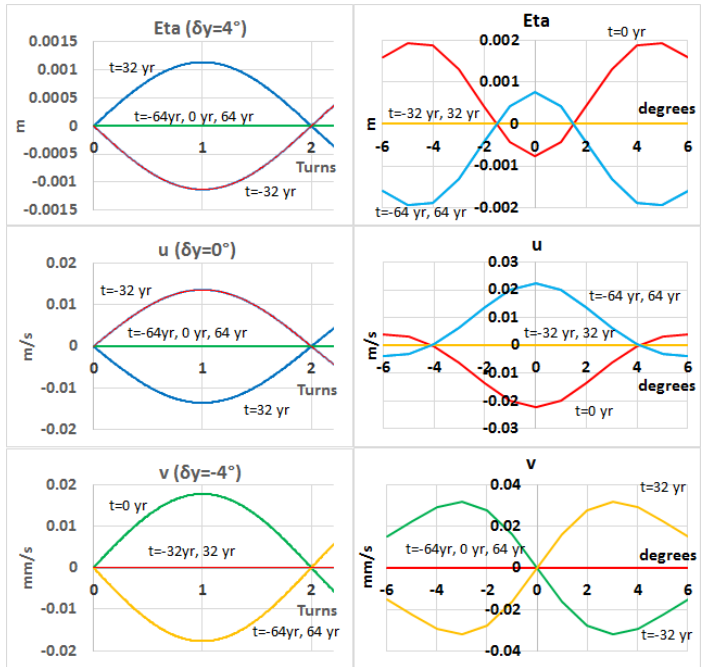
Figure 5. The solution of the equations of motion in the simple case of uniform forcing around the gyre for the 128-year period. The surface height perturbation 𝜂 , the polar current 𝑢 and the radial current 𝑣 are represented: (1) on the left versus the ratio of the circumference of the gyre on the apparent half-wavelength, for various times 𝑡 compared with the maximum solar irradiance; 2 windings are around the gyre. 𝛿𝑦 represents the distance to the midline of the gyre; (2) on the right versus the radius of the midline of the gyre (1 degree = 111.3 km).